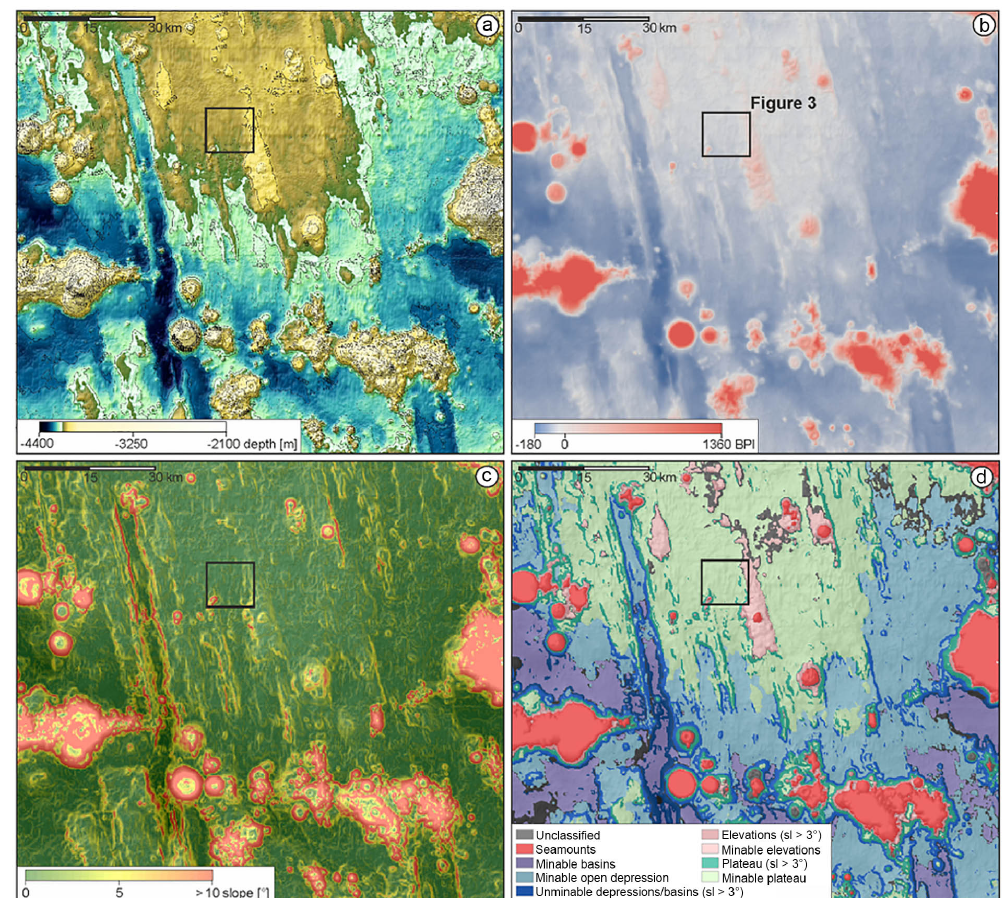
Figure 2. Overview maps of PA1 showing (a) bathymetry, (b) bottom positioning index (BPI) with scale factor 11000 (grid cell size: 110m, inner radius: 10 cells, outer radius: 100 cells), (c) slope and (d) classification of the terrain based on the classification dictionary in Table A2 (sl indicates slope). The terms “mineable” and “unmineable” are defined by the slope threshold (here, mineable indicates where the slope ≤ 3 ◦ , and unmineable indicates where the slope > 3 ◦ ; this is a rather conservative threshold, as current discussions mention 7 ◦ as more realistic). Black squares mark the study area (center at 117 ◦ 1 (cid:48) W 11 ◦ 51 (cid:48) N) shown in Fig.